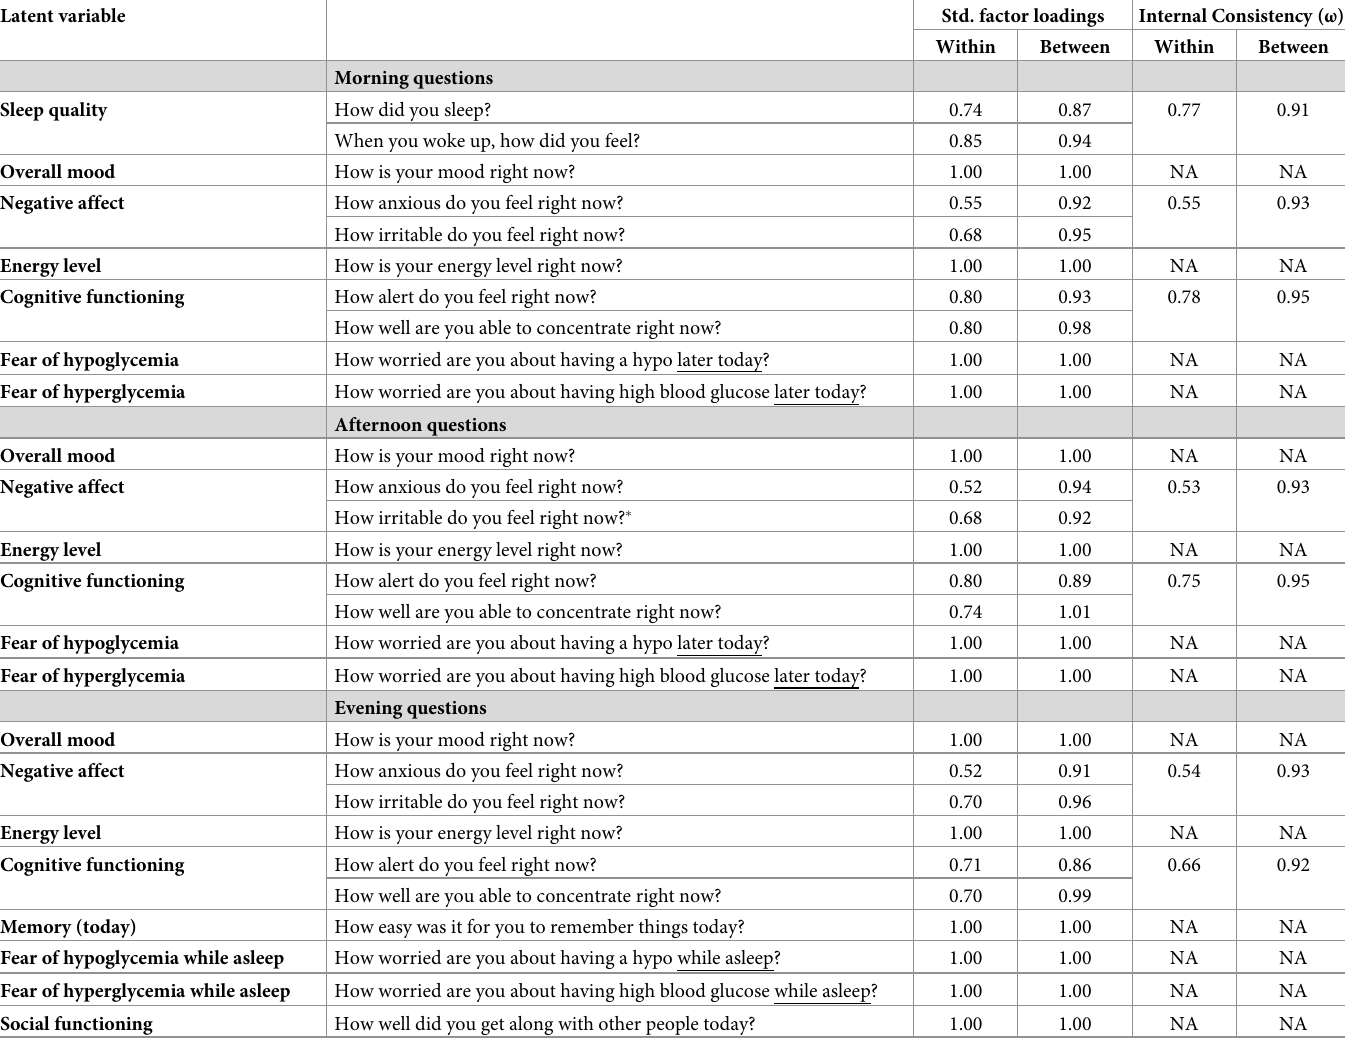
Table 4. Standardized factor loadings and internal consistency measures (adjusted model